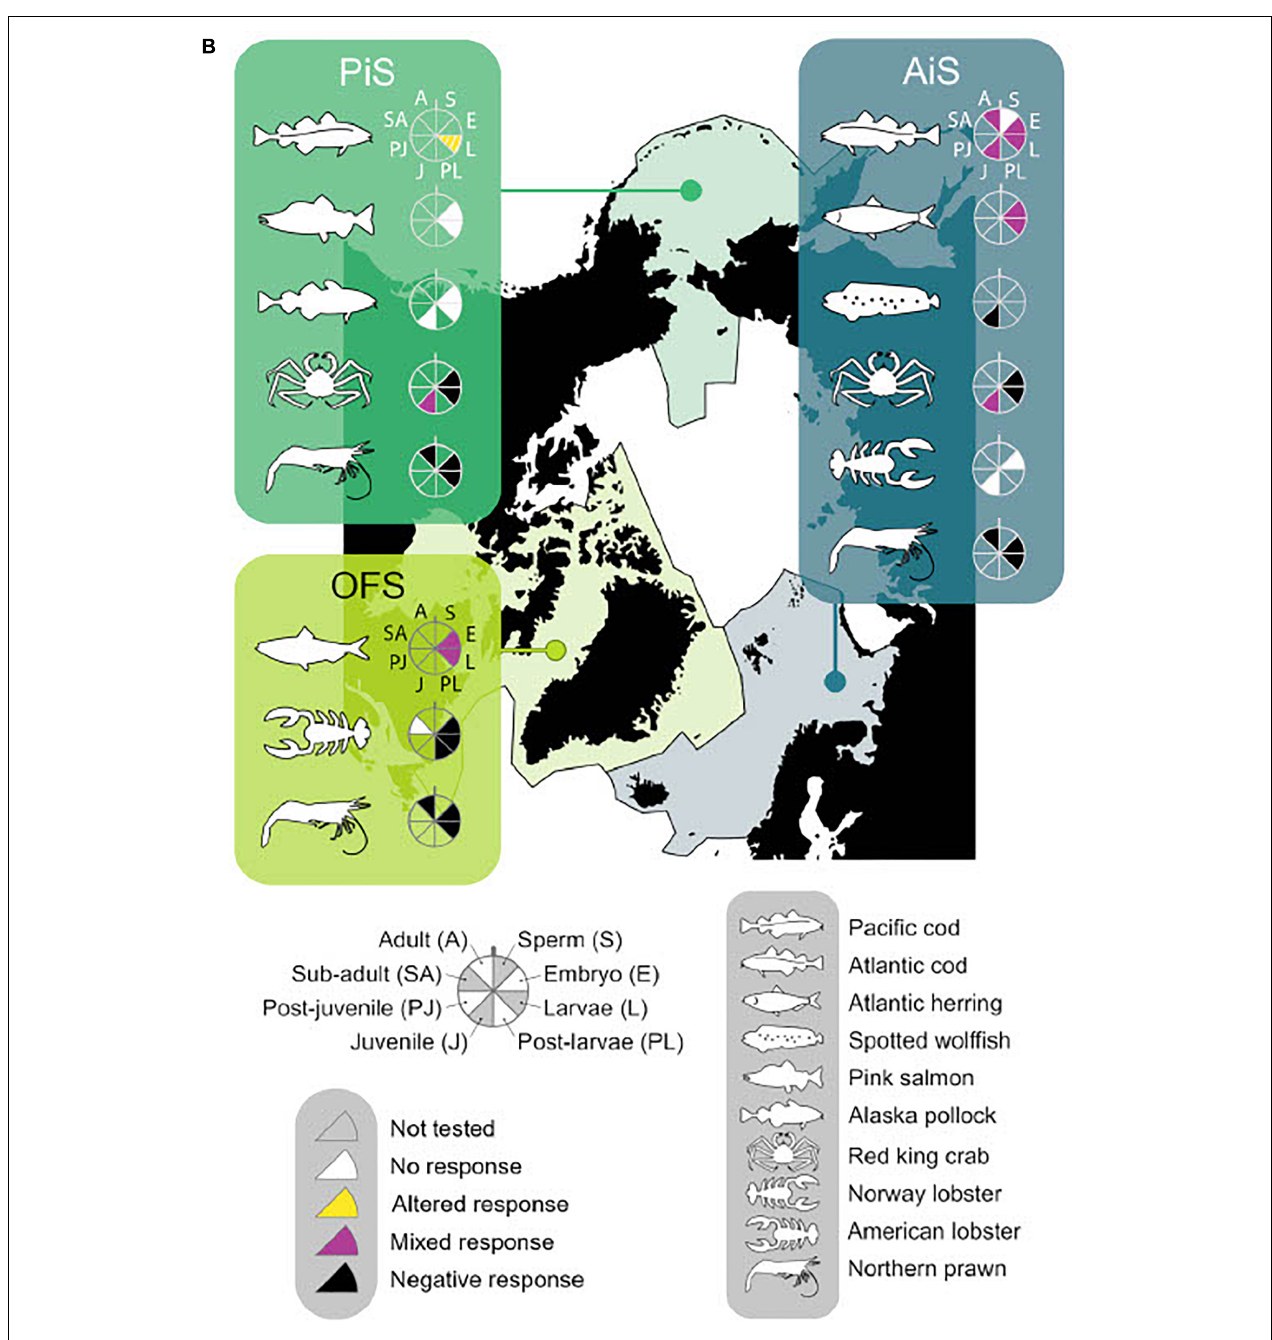
FIGURE 1 | (A) Arctic regional map showing different stressors for each region. AiS, Atlantic influenced seas; PiS, Pacific influenced seas; RiS, river influenced seas; CAO, central Arctic Ocean; OFS, outflow shelves (more detail refer to Supplementary Table 4 ). (B) Species icons represent each commercial species where response OA has been studied. Black = negative response, white = no response, blank = not tested, yellow = significantly altered response, purple = mixed response (this includes both positive, negative and significant altered response for more detail refer to Supplementary Table 1 ). Each life stage tested is represented by the slice of the wheel next to icon of